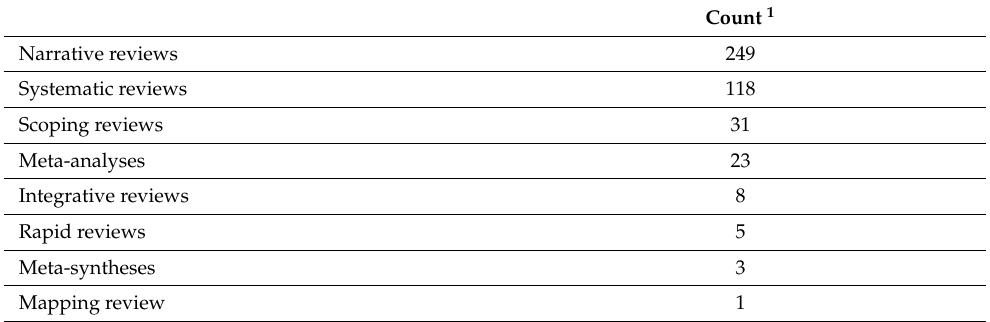
Table 5. Thematic Focus of Included Articles. 1